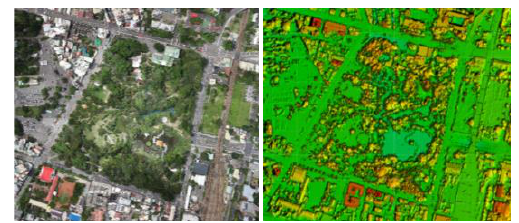
Figure 17 Orthophoto and DTM result